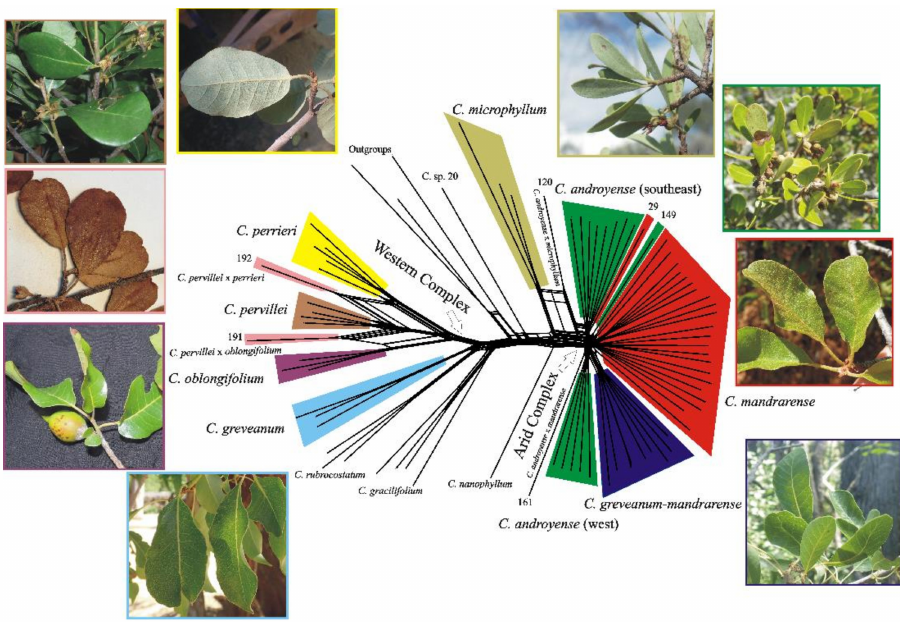
Figure 4. Split network computed from uncorrected P-distances and a concatenated supermatrix of exonic regions from 600 genes and 81 specimens. Splits and picture margin are color-coded according to morphospecies and specimens detected as hybrids are indicated. Numbers refer to specimens in Table 2. (Outgroups: Bemangidia lowry , Capurodendron delphinense and C. birkinshawii